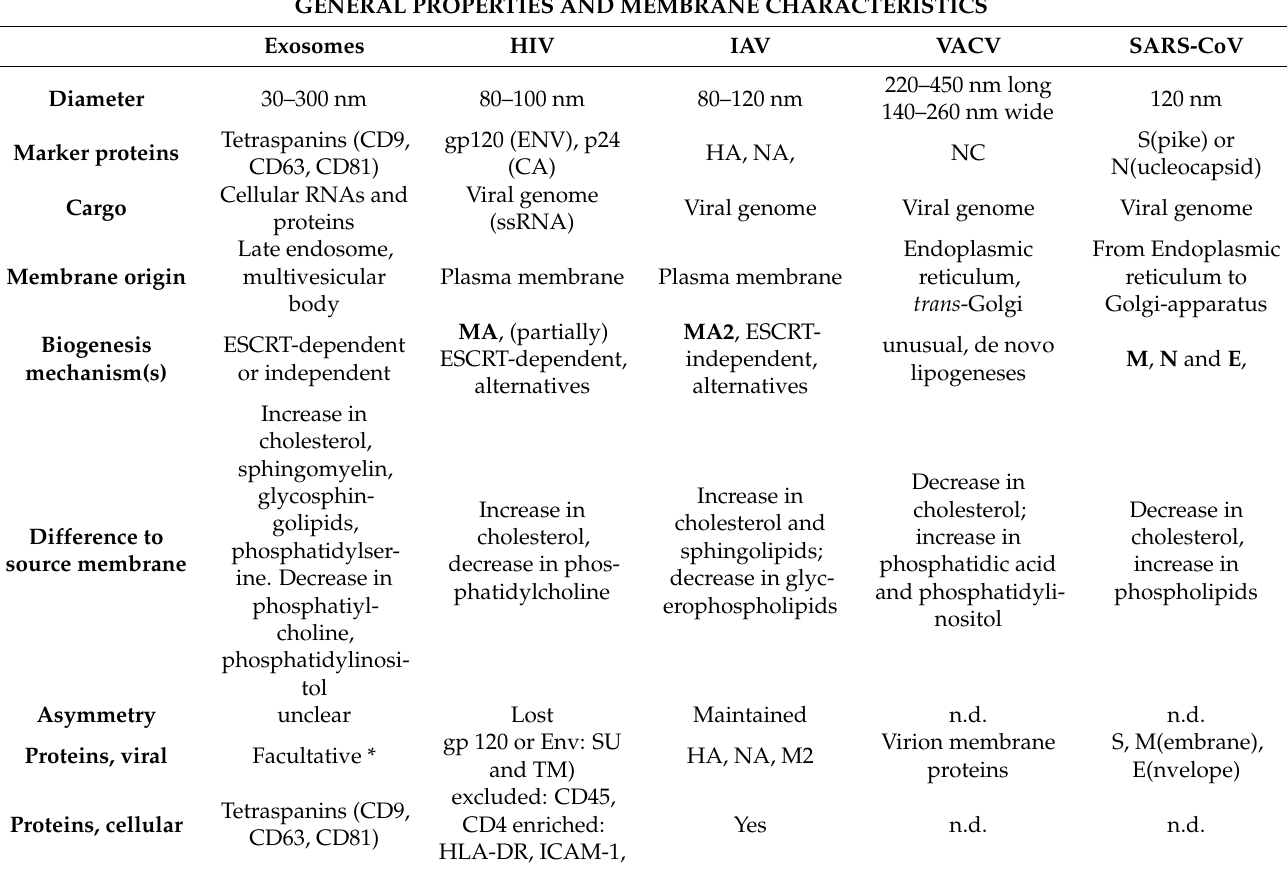
Table 2. EXO and EVI